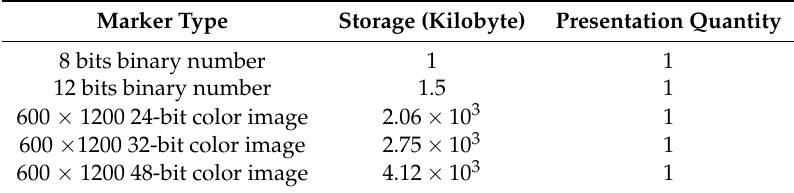
Table 3. Comparison of absorbed storage by different marker